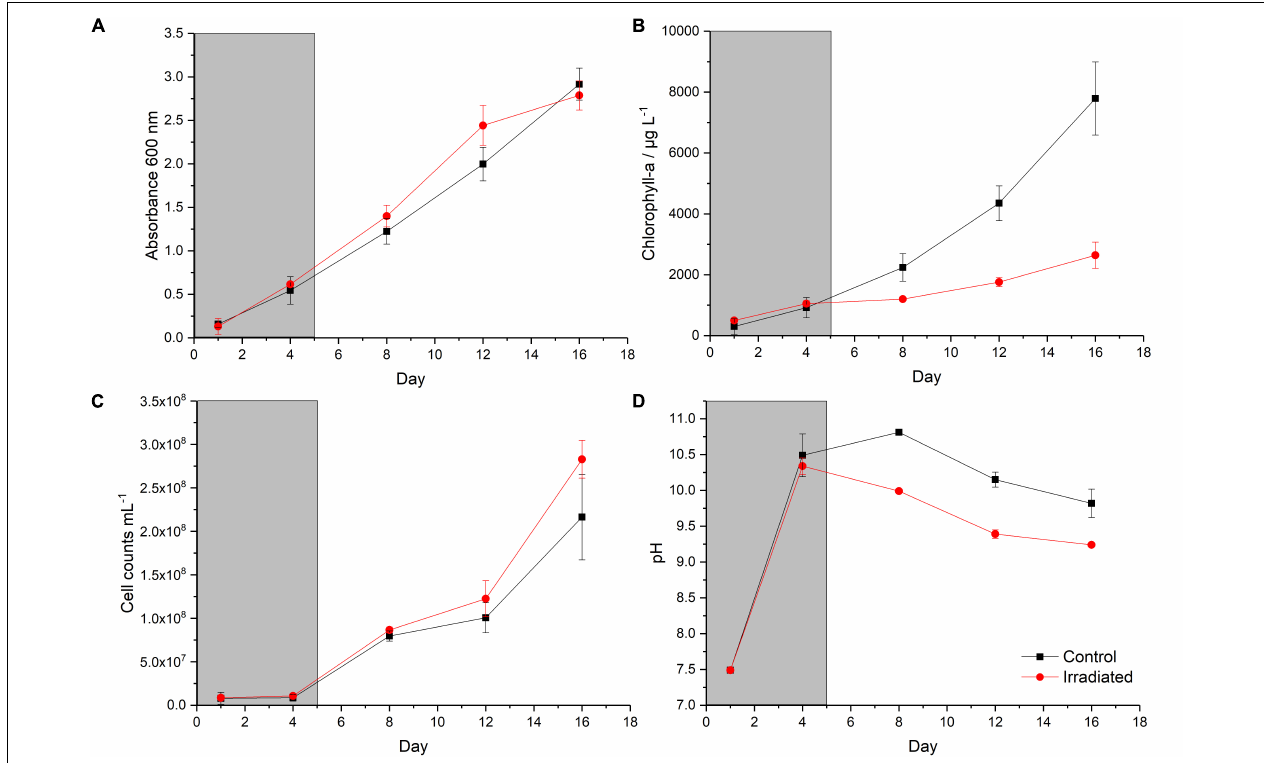
FIGURE 1 | Growth of the P. catenata culture with and without radiation treatment: (A) absorbance at 600 nm; (B) chlorophyll-a concentration ( µ g L - 1 ); (C) mean cell counts of P. catenata ; (D) pH. The gray panel indicated the period in which the irradiation treatment was being administered. Red lines are irradiated samples; black lines are control samples. Error bars are the standard deviation of three